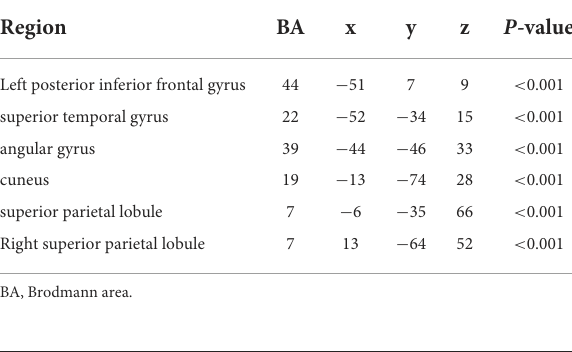
TABLE 1 The area of increased activation by the interaction effect between condition and time.